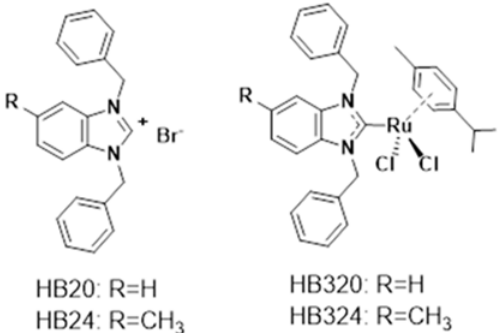
Figure 1. Ruthenium complexes and their benzimidazolim precursors investigated in this report.